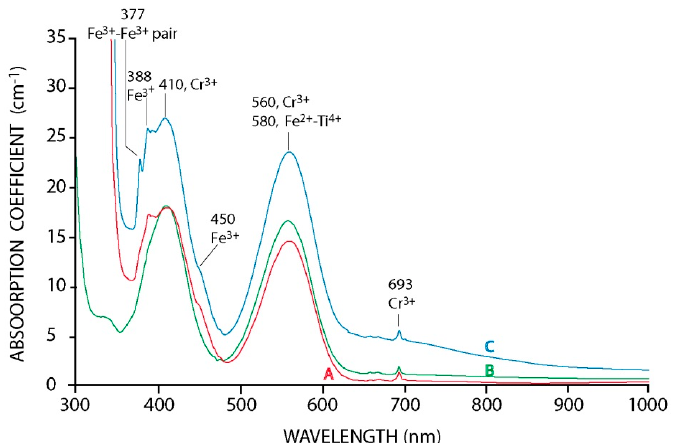
Figure 6. Ultraviolet, visible, and near infrared (UV-Vis-NIR) spectra of rubies from the Maninge Nice and Mugloto deposits, Mozambique; modified from [26]. The three spectra show the Cr 3+ absorption bands at 410 and 560 nm, and the Cr 3+ “doublet” at 694 nm. Spectrum ( A ) of a ruby from Mugloto also shows the shoulder at 330 nm but in addition a single Fe 3+ feature at 377, 388, and 450 nm that reflects a higher Fe content in this ruby. Spectrum ( B ) of a ruby from Maninge Nice shows a shoulder at 330 nm caused by Fe 3+ pairs. Spectrum ( C ) of a ruby from Mugloto differs from the others mainly by a Fe 2 + → Ti 4 + charge transfer band centered at 580 nm and increasing absorption above 600 nm.